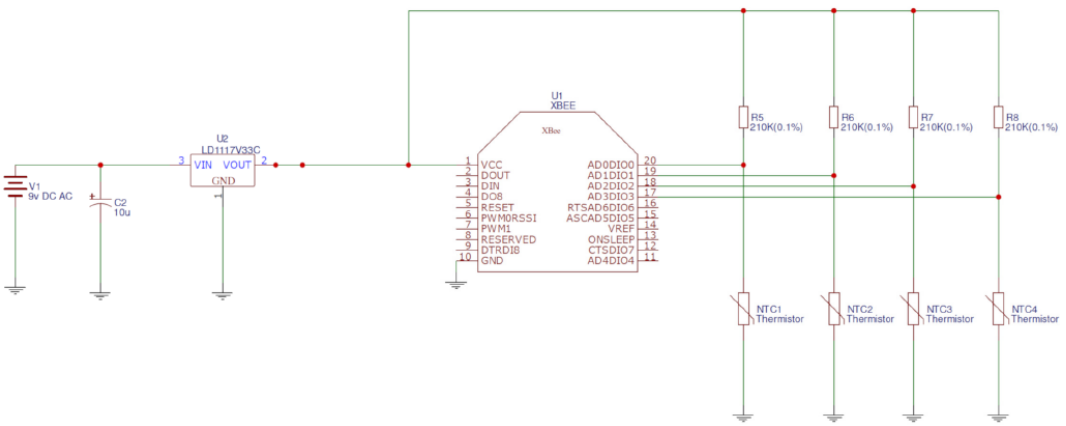
Figure 3. Node electrical